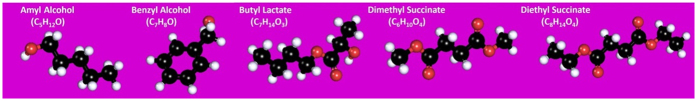
Molecular structure of selected odorants.